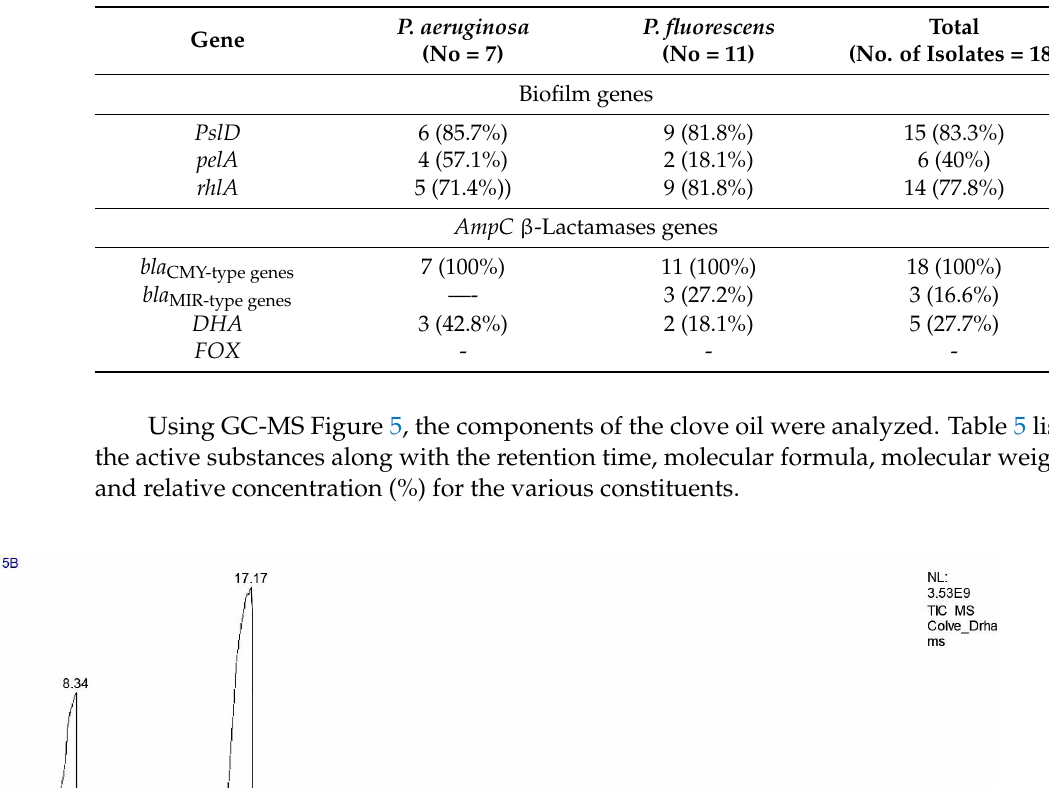
Table 4. PCR results of biofilm formation and antimicrobial resistance genes in Pseudomonas spp.